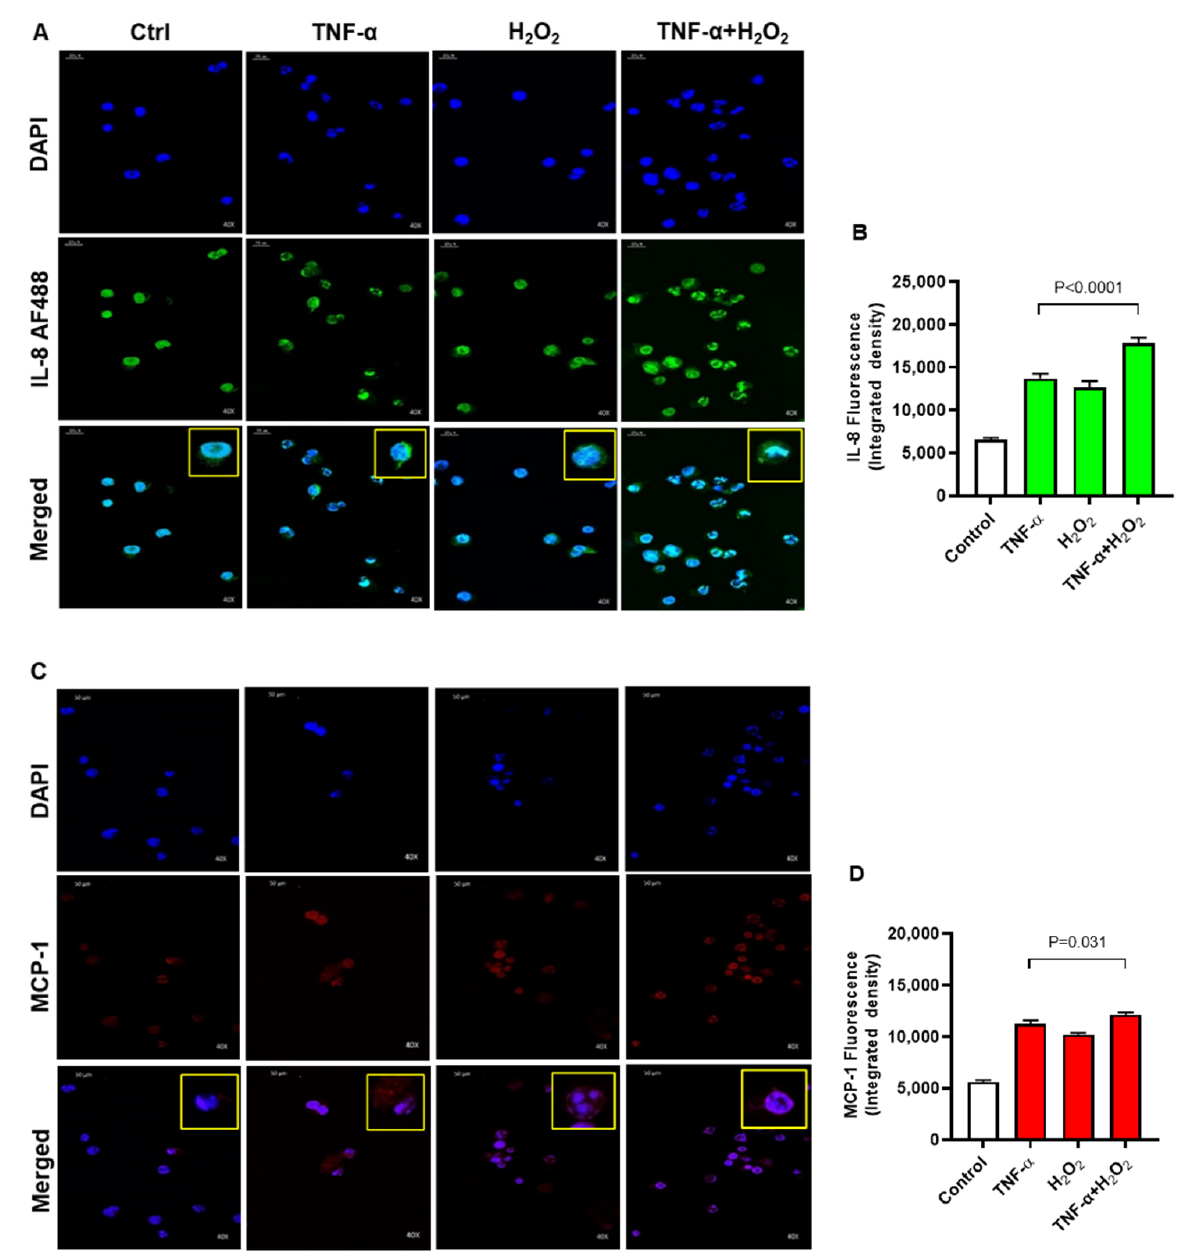
Figure 4. IL-8 and MCP-1 protein expression were determined by confocal microscopy. THP-1 cells were stimulated, in triplicate, with TNF- α (10 ng/mL) and/or H 2 O 2 (10 mM) for 24 h, while control cells were treated with vehicle only. IL-8 and MCP-1 protein expression (fluorescence assessed as integrated density) was determined by confocal microscopy as detailed in materials and methods. For IL-8 and MCP-1 protein quantification, 10 random images (40 × magnification) were captured for each treatment. The fluorescent channels were split using image J software (NIH, USA). The fluorescence intensity of IL-8 and MCP-1 was detected in 10 fields of each image and mean integrated density was calculated for each image. One-way ANOVA (Tukey’s multiple comparisons test) was used to calculate group differences and p -values less than 0.05 were considered as significant. The representative photomicrography images (40 × magnification) obtained from three independent determinations with similar results show elevated expression of ( A , B ) IL-8 ( p < 0.0001) and ( C , D ) MCP-1 ( p = 0.031) in the cells co-stimulated with TNF- α and H 2 O 2 as compared with cells stimulated with TNF- α or H 2 O 2